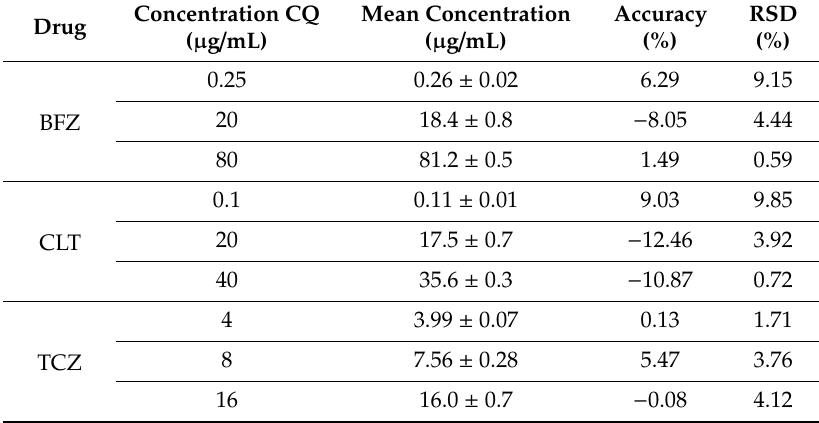
Table 9. HPLC method robustness. Results are expressed as mean ± SD (n =